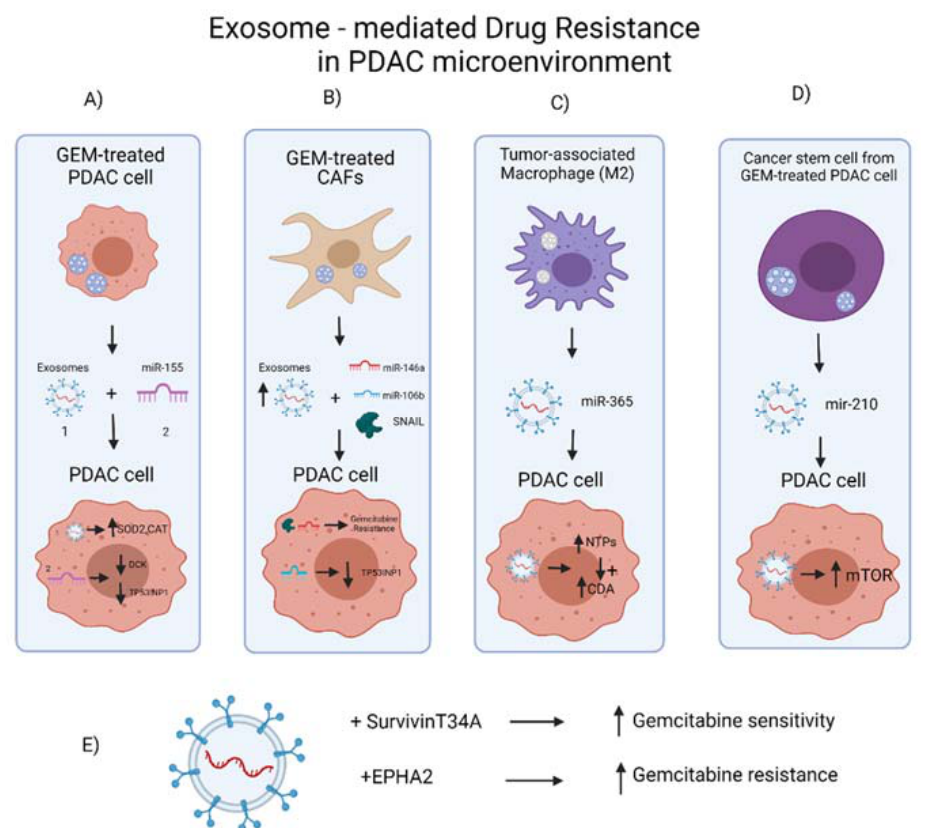
Figure 3. The contribution of the PDAC microenvironment to the generation of drug resistance. ( A ) GEM-treated PDAC cells secrete miR-155 through exosomes enhancing the antioxidant capacity of cancer cells (through the downregulation of SOD2 and CAT), disrupting the activation of GEM (through the downregulation of DCK) and cellular stress-sensing systems (by upregulating TP53INP1). ( B ) GEM-treated CAFs exosomally secreted miR-106b, miR-146a, and Snail, all of which mediate their intrinsic resistance to GEM. ( C ) The M2-derived exosomally excreted miR-365 increased the intracellular NTP pool and the CDA. ( D ) GEM-resistant cancer stem cells secreted through exosomes miR-210 induced drug resistance through mTOR signaling potentiation. ( E ) The knockdown of EPHA2 in drug-resistant cells decreased their efficiency in transmitting GEM resistance. Created with